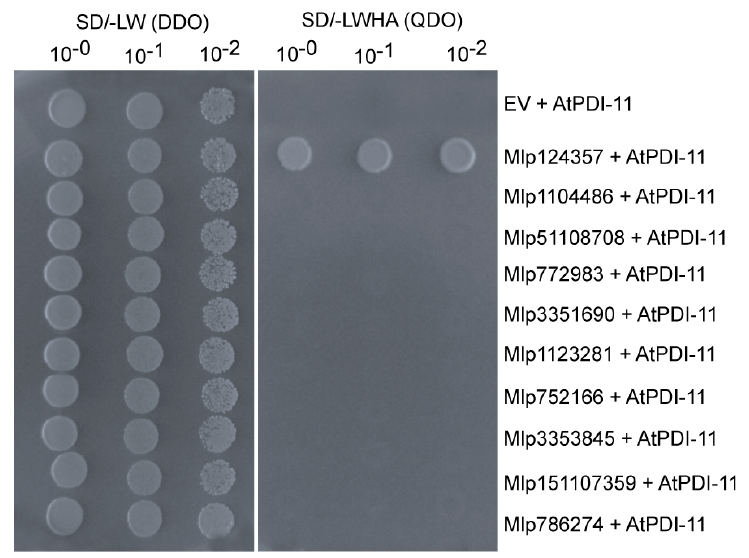
Figure 6. The Mlp124357-PDI association takes place in an effector-specific manner. Co-expression of Mlp3351690, Mlp1123281, Mlp752166, Mlp3353845, Mlp151107359, or Mlp786274 as baits in